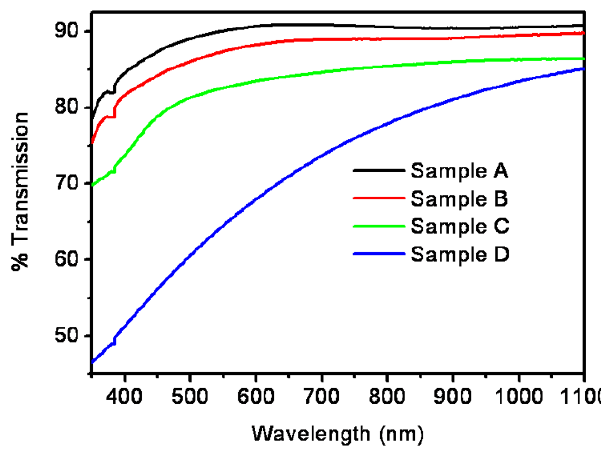
Figure 9. Transmission spectra of as-deposited and RTA porous GaAs.